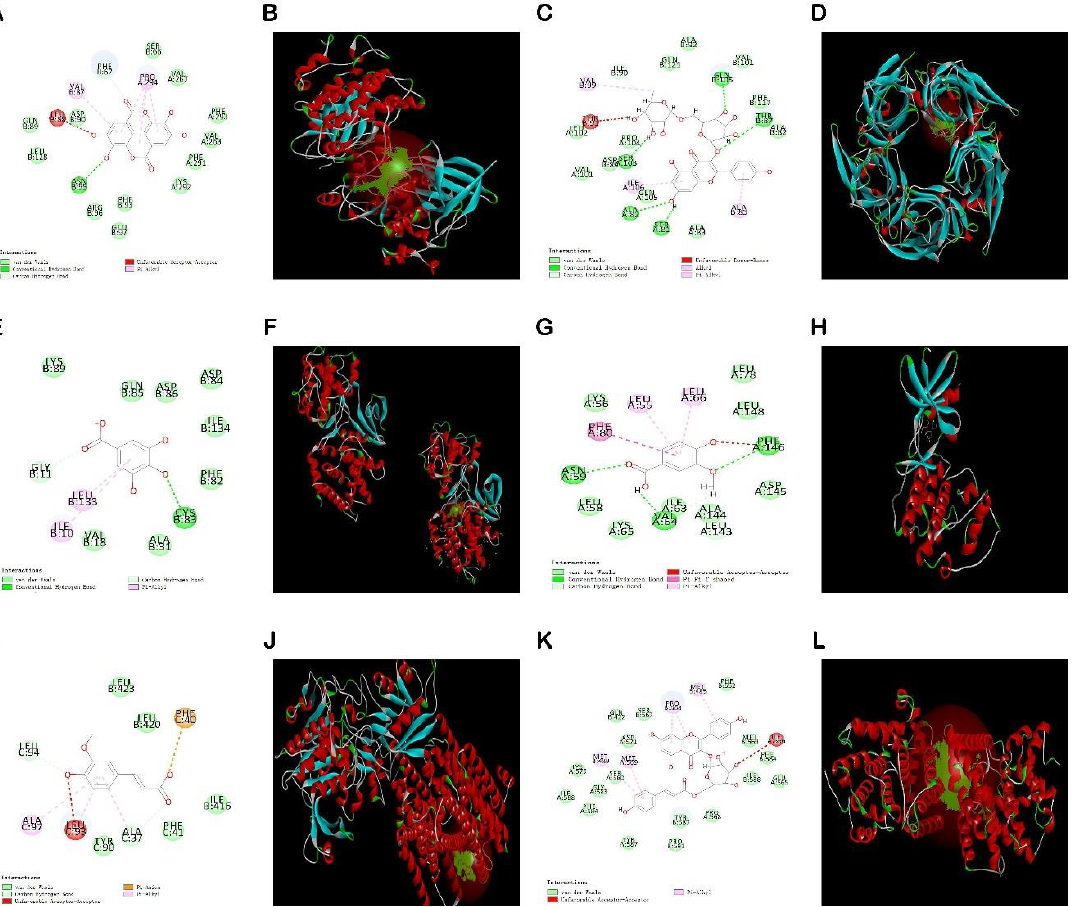
Figure 14. Docking results of six compounds with the highest matching target proteins: EA-GSK3 β ( A and B ), KA- α 7nAchR ( C and D ), GA-CDK5 ( E and F ), VA-CDK5 ( G and H ), FA- γ secretase ( I and J ), TI-PDE4A ( K and L ). 2D molecular docking diagrams are represented by ( A ) Ellagic acid, ( C ) Kaempferol-3-o-rutin glycoside, ( E ) Gallic acid, ( G ) Vanillic acid, ( I ) Ferulic acid, and ( K ) Tiliroside; and 3D molecular docking diagram are represented by ( B ) Ellagic acid, ( D ) Kaempferol-3-o-rutin glycoside, ( F ) Gallic acid, ( H ) Vanillic acid, ( J ) Ferulic acid, and ( L ) Tiliroside,